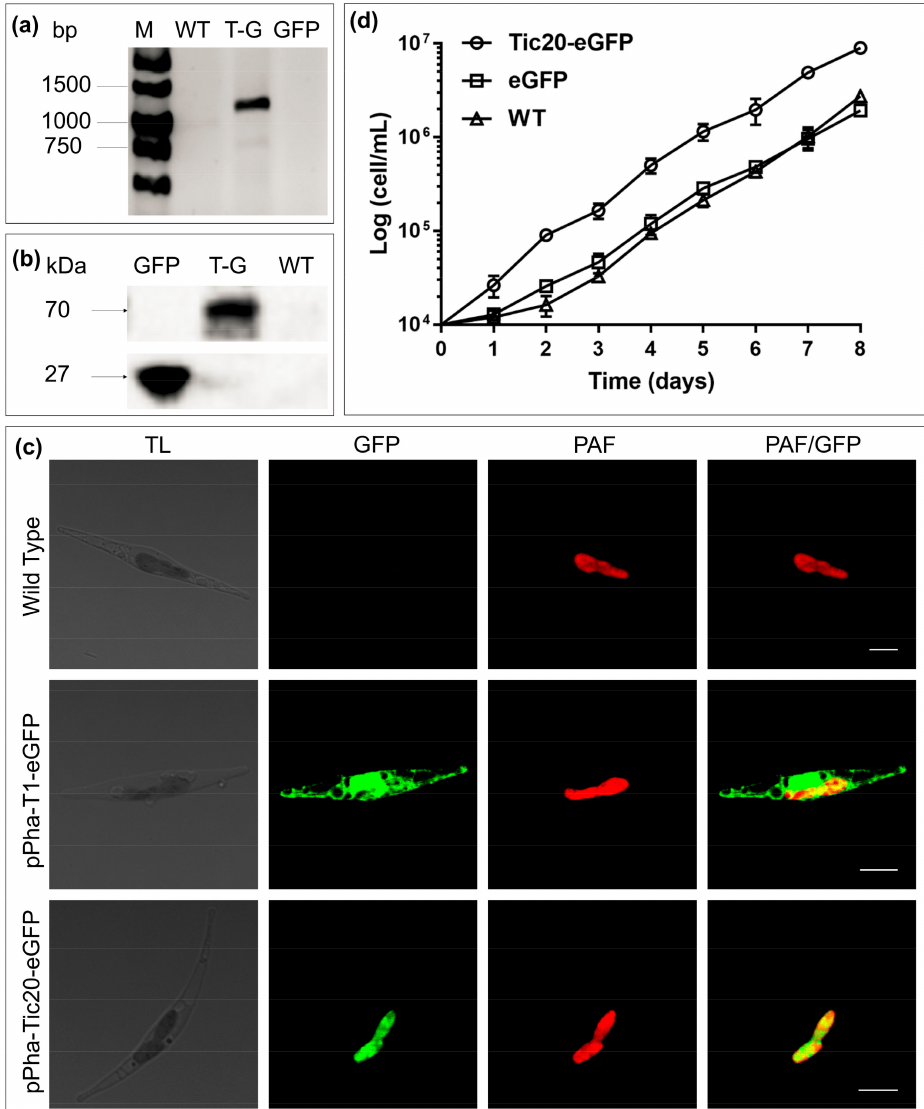
Figure 4. Transgenic diatom growth and observation of the fusion of SjTic20-14 and eGFP. ( a ) PCR detection of the SjTic20-eGFP sequence. WT: wild-type diatom, T-G: diatom expressing full-length SjTic20-eGFP; GFP: diatom expressing only eGFP (same below). ( b ) Total protein western blot for detection of the expression of eGFP: eGFP alone has a molecular weight of 26 kDa, and SjTic20-eGFP has a putative molecular weight of nearly 70 kDa. ( c ) Fluorescence laser scanning confocal microscopy observation. pPha-T1-eGFP: transformation of eGFP alone; pPha-Tic20-eGFP: transformation of SjTic20 fused to eGFP; TL: transit light; GFP: green fluorescence; PAF: plastid autofluorescence; PAF / GFP: overlay of plastid and green fluorescence; scale bar represents 5 µ m. ( d ) Growth curve of diatom strains. Diatom strain expressing SjTic20-eGFP (curve with circles), wild-type strain (curve with triangles) and strain expressing eGFP alone (curve with